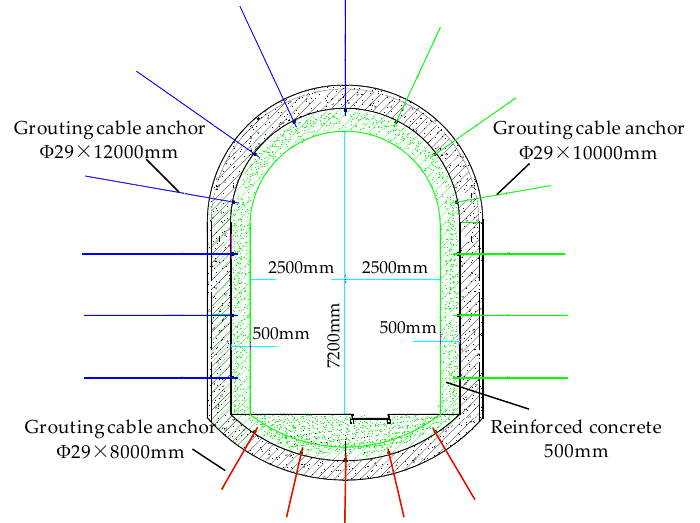
Figure 10. Schematic diagram of reinforcement scheme.